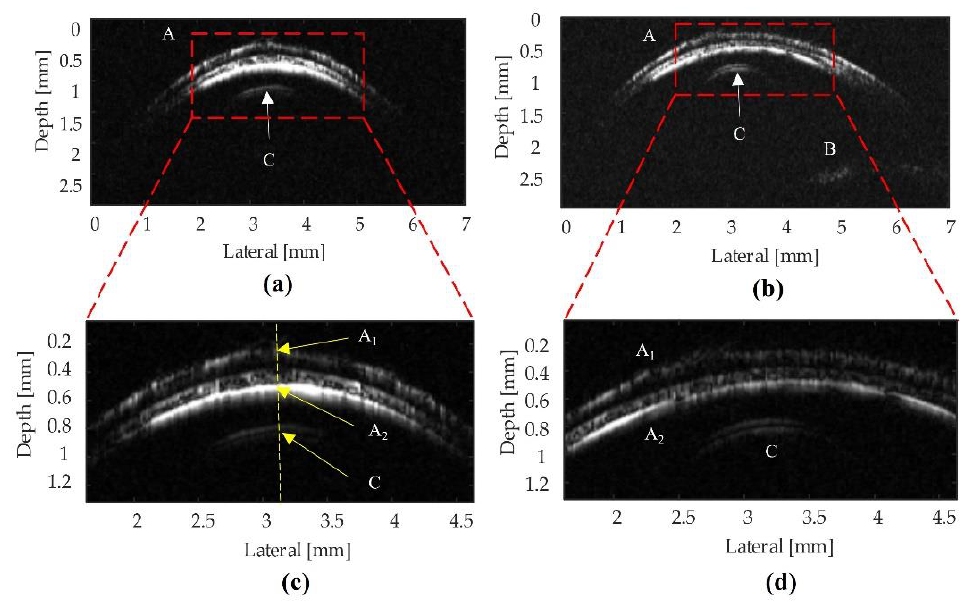
Figure 9. After performing the mass–spring matching layer technique, a UBM of the fish eye obtained was obtained with ( a ) the 103 MHz PMN-0.3PT transducer and ( b ) the 105 MHz LiNbO 3 transducer. ( c , d ) Enlarged view of the center of the cornea. The cornea (A), upper cornea surface (A 1 ), lower cornea surface (A 2 ), iris (B), and lens (C) are visible.